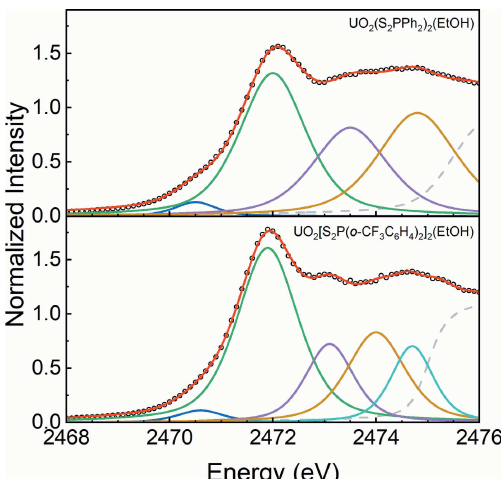
Figure 4 Curve-fitting results of S K -edge XAS for UO 2 (S 2 P R 2 ) 2 (EtOH). The experimental data are shown by black circles, and the total curve fits are shown by red traces. Post-edge residuals (dashed gray traces) are generated by subtracting the pre-edge pseudo-Voigt functions (blue, green, purple, yellow, light blue) from the total curve fits.